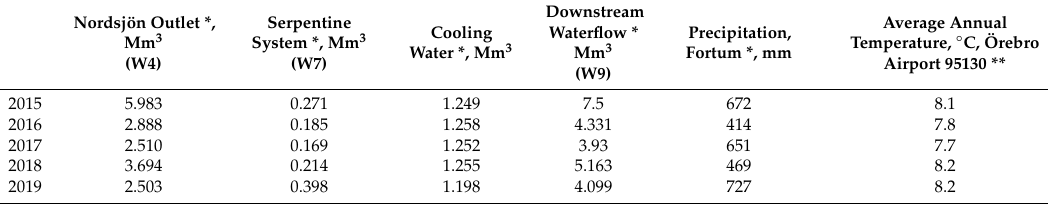
Table 4. Water flow, precipitation and temperature 2015–2019.